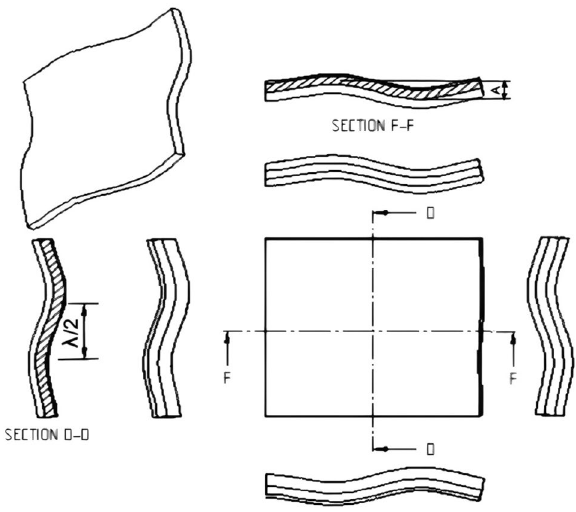
Figure 4. The design of the specific corrugated